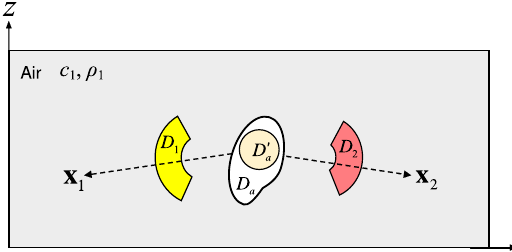
Figure 1. Sketch of the problem geometry showing the near controls D 1 , D 2 and the far fi eld directions x 1 and x 2 in free